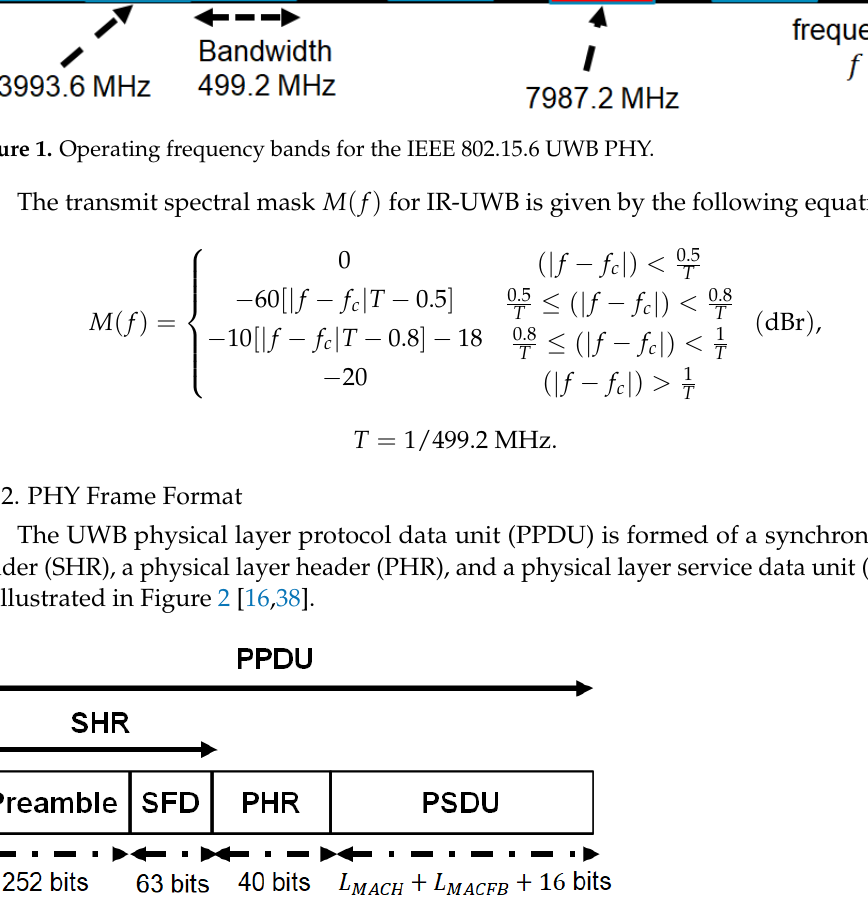
Figure 2. PPDU Figure 2. PPDU structure.